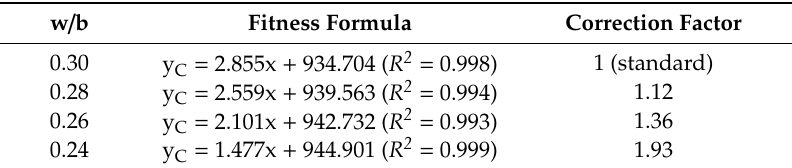
Table 7. Carbonation depth calibration procedure.